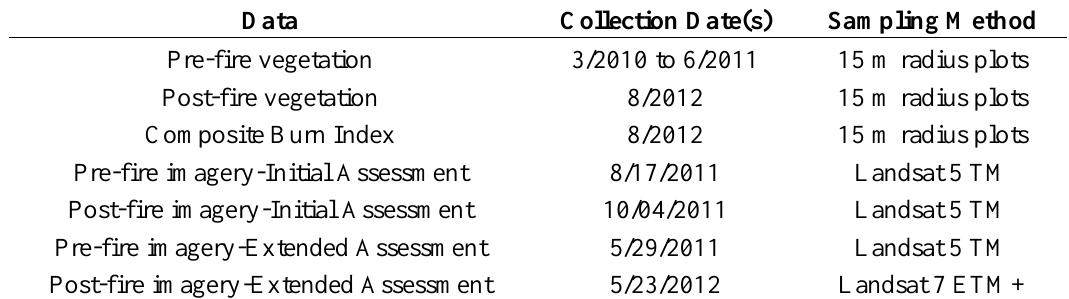
Table 1. Data collection dates and methods for vegetation plots, the composite burn index (CBI), and satellite imagery-based initial and extended assessments of fire